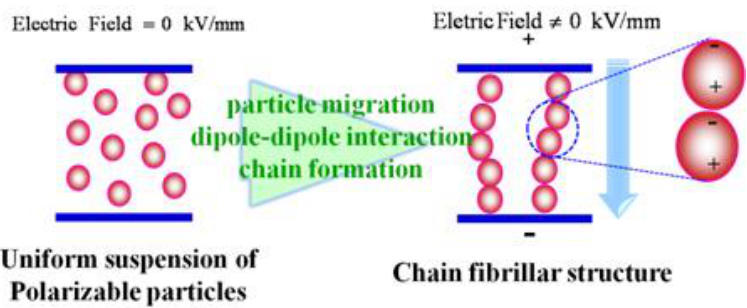
Figure 1. Schematic diagram of ER fluid system with and without an applied electric